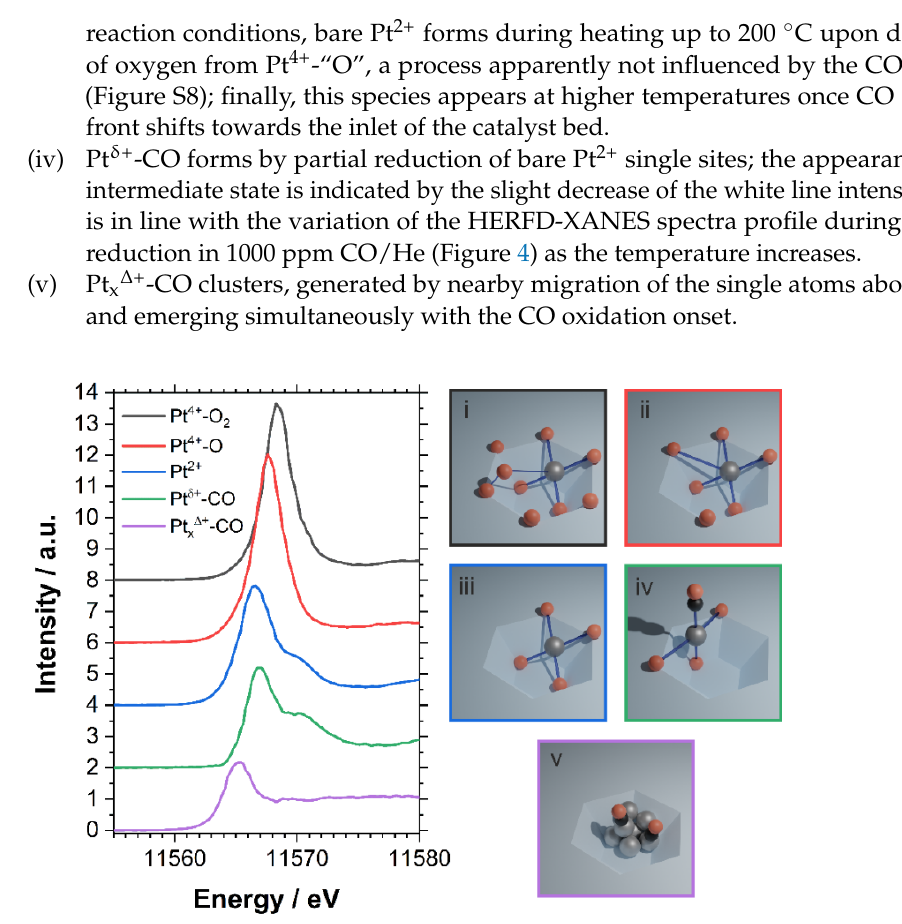
Figure 5. Reference HERFD-XANES spectra of pure Pt species present during CO conversion as determined via MCR-ALS (left) and corresponding schematic representation of the structure of the identified species (right; grey metallic spheres represent Pt atoms, red: O and black C). See text for detailed description of structures ( i )–( v ) shown on the